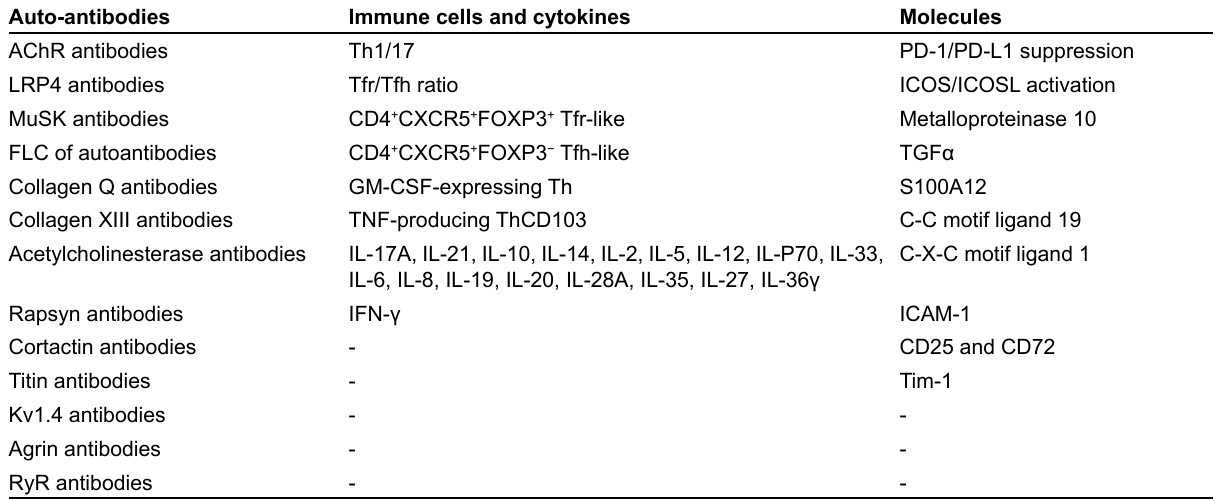
Table 1. The immunologic biomarkers of